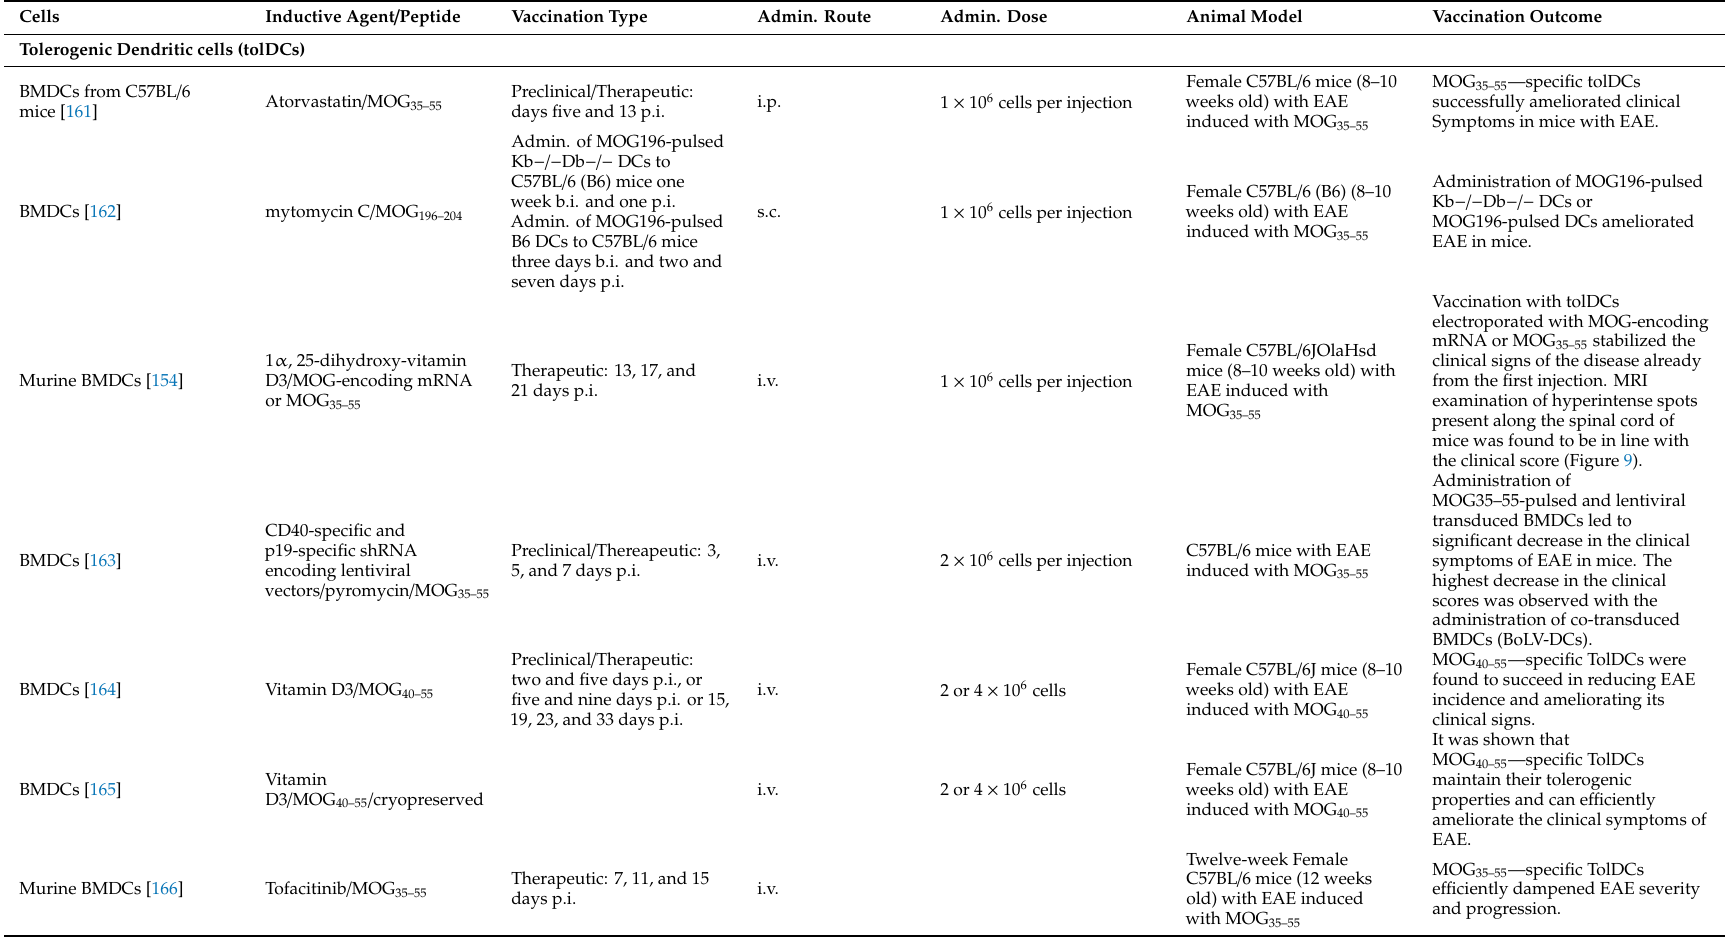
Table 4. Cell-based